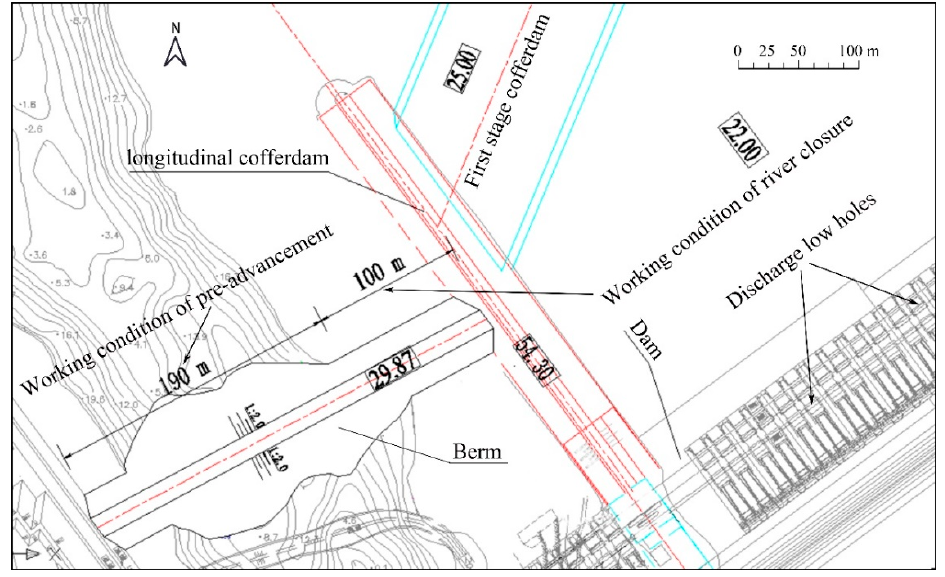
Figure 6. Description of working condition.